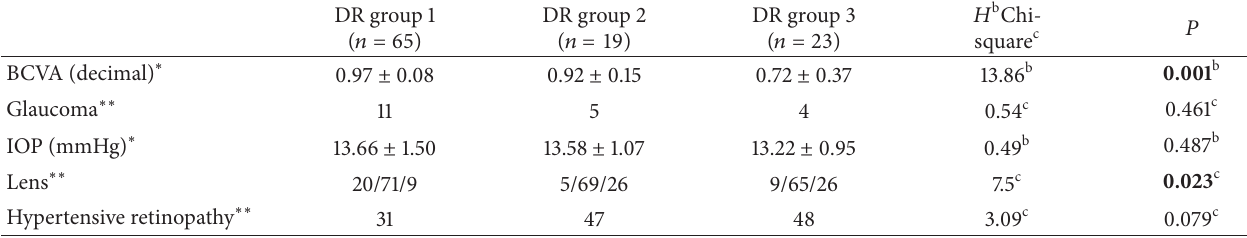
Table 1: Ophthalmologic parameters of type 2 diabetic patients ( 𝑛 = 107 ) divided into three groups according to the diabetic retinopathy